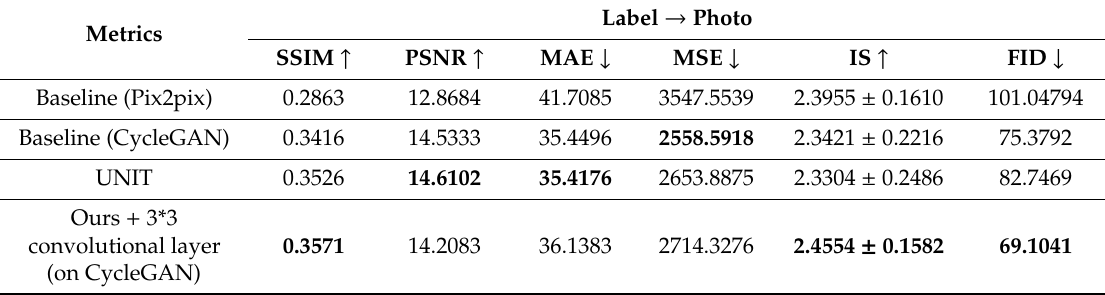
Table 1. Evaluation of baseline models and our model on the cityscapes dataset (label → photo).